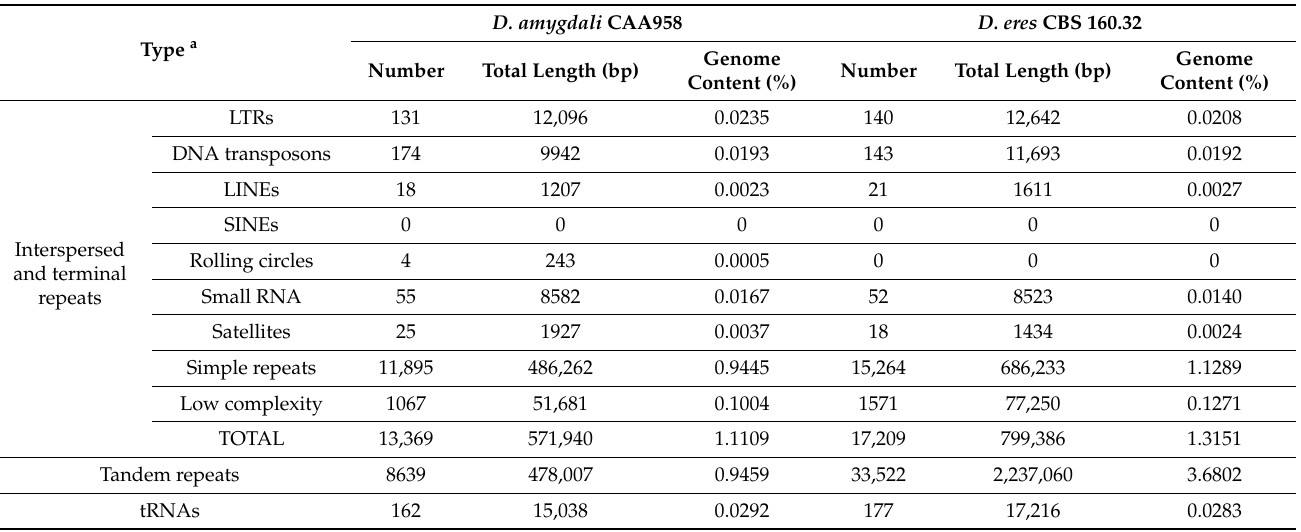
Table 2. Statistical results for repetitive sequences, tandem repeats, and tRNAs in Diaporthe amygdali CAA958 and Diaporthe eres CBS